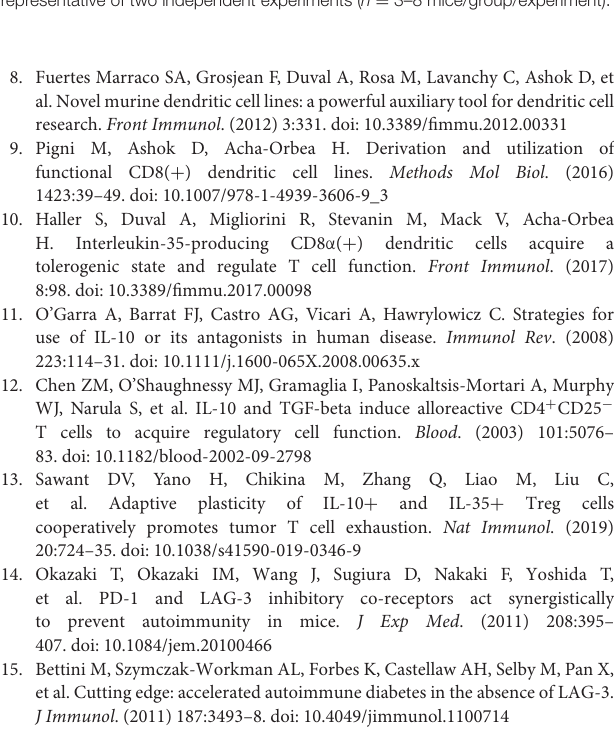
Supplementary Figure 1 | Phenotypical characteristics of the IL10-DC line after transduction. Cells were analyzed for the indicated surface markers by Flow cytometry after lentiviral transduction. Data are representative of three independent experiments. Supplementary Figure 2 | IL10-DC induce antigen-specific T cell proliferation. 5 × 10 3 transduced or untransduced DCs were seeded in 96-well plates and pulsed with OVA 257 − 264 peptide (SIINFEKL), OVA 323 − 339 peptide (OT-II peptide), or full-length ovalbumin (100 µ g/mL) for at least 2h before adding 5 × 10 4 of naïve proliferation dye-labeled OT-I CD8 + or OT-II CD4 + T cells. Cells were left in co-culture with peptide-pulsed DCs for 3 days or with OVA-pulsed DCs for 4 days. Flow cytometric analysis of (A) CD8 + T cell proliferation, (B) perforin, and (C) granzyme B expression on CD8 + T cells; (D,E) CD4 + T cell proliferation. Data are representative of at least three independent experiments. Bar graphs indicate the mean of technical replicates in one representative experiment. Supplementary Figure 3 | The combination of IL10-DC and IL35-DC lines reduced the IgG1-CII antibody levels in CIA sick mice. Blood serum samples from sick mice were obtained after 28 days of CIA induction. (A) Collagen II-specific IgG1 and IgG2a antibodies. (B) Ratio between the average concentration of CII-specific antibodies in DC-injected mice and non-injected mice. Data are representative of two independent experiments ( n = 3–8